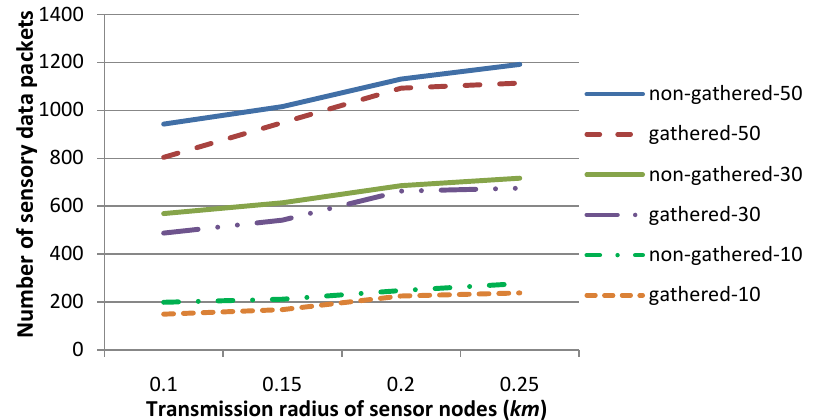
Figure 9. Comparison of the number of sensory data packets when the transmission radius r is set to various values, for the strategies that sensory data are gathered, or not gathered, by relay nodes. This number that non-gathered strategy requires, especially when r is set to a relatively small value.